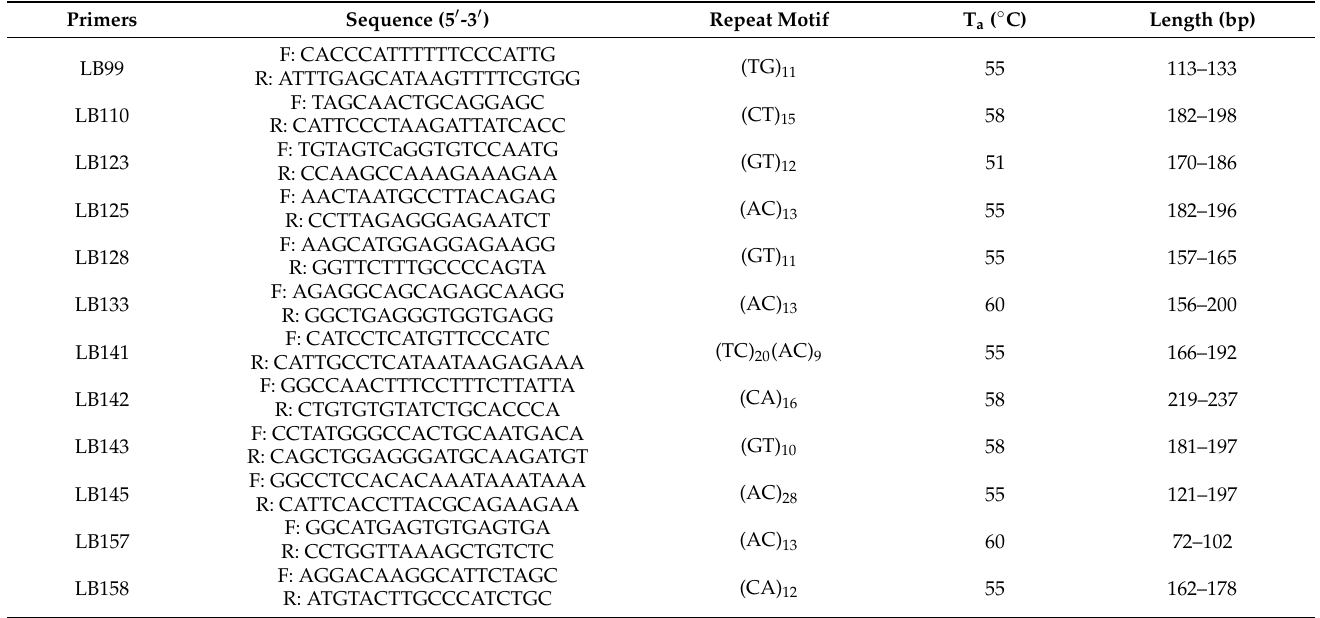
Table 2. Nucleotide sequences of microsatellite primers used in this